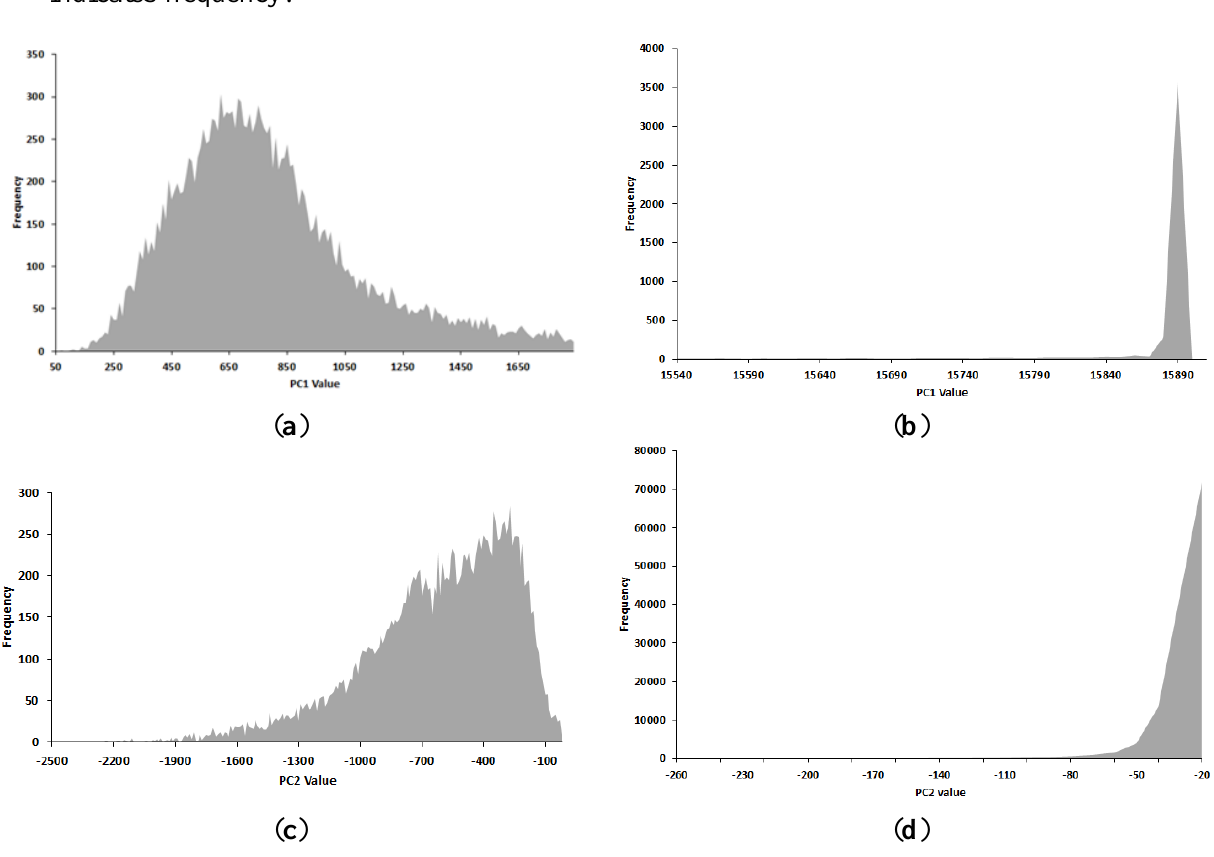
Figure 8. PC value about each part by histogram: ( a ) crack (PC1); ( b ) stem (PC1); ( c ) crack (PC2); and ( d ) sound area (PC2). The x-axis indicates PC value and the y-axis indicates frequency.